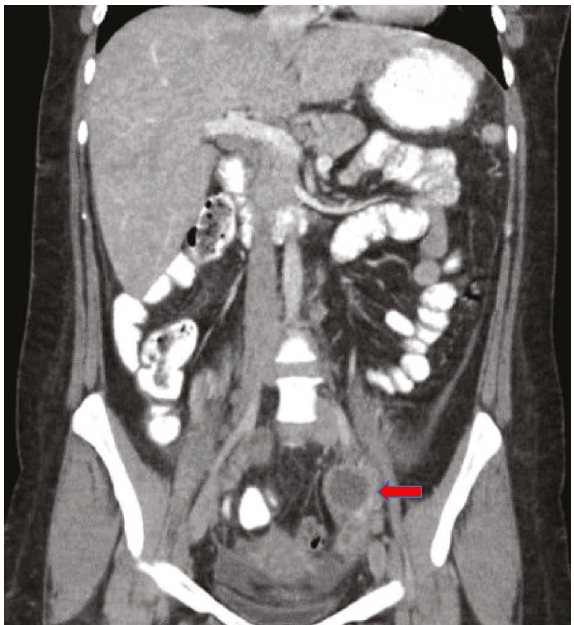
Figure 1: Coronal view of the lesion within the left adnexa, which contains a thin septation measuring 4.3cm and adjacent free fluid extending to the posterior cul-de-sac and a homogeneously en- larged